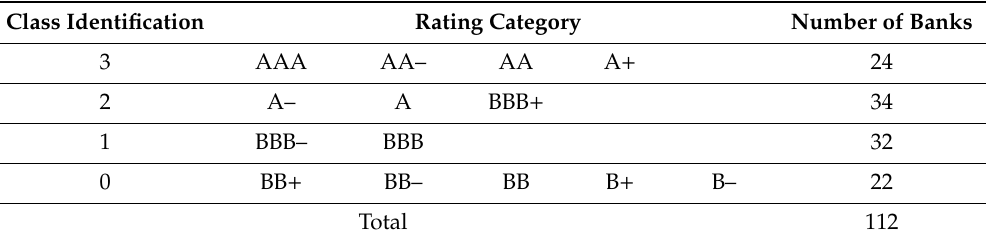
Table 2. Grouping of Bank ratings in